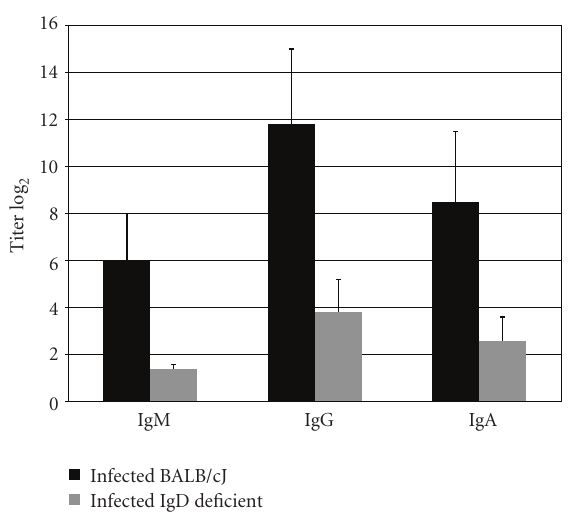
Figure 2: P. gingivalis- specific serum antibody titers of all three isotypes were significantly lower in infected IgD deficient mice compared with immune normal BALB/cJ mice ( P < . 05). Bars represent the mean anti- P. gingivalis titer of infected mice ± SEM ( n = 10) after subtraction of the mean value for sham-infected mice of the same strain.